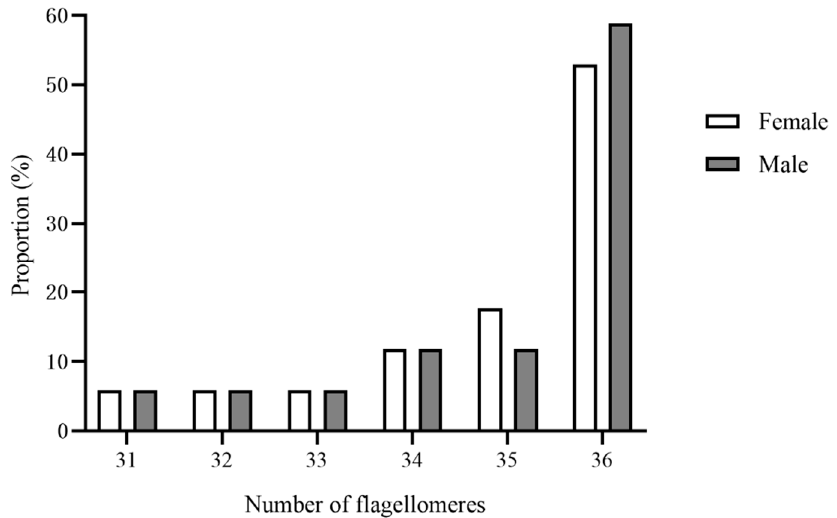
Figure 3. Proportion of total number of antennal flagellomeres in female and male C. qinlingensis ( n = 34).